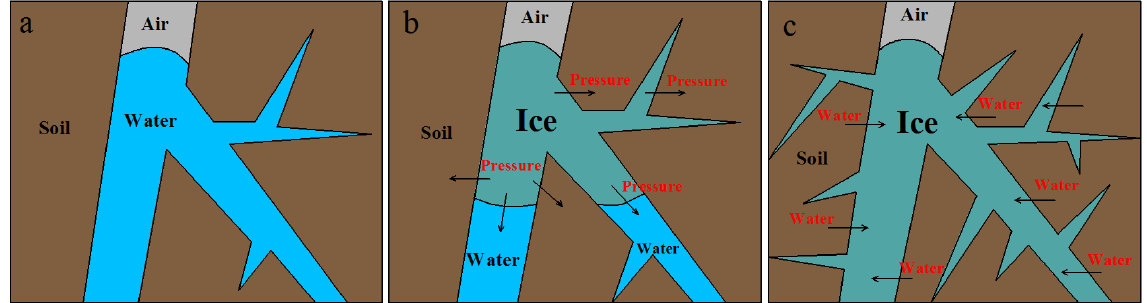
Figure 1. The phase change and migration of soil moisture during freezing process. ( a ) Three-phase distribution of solid, liquid and gas in soil before freeze; ( b ) During the freezing process, the upper layer of soil pore water begins to freeze, producing pressure on the surrounding soil and the lower layer of water; ( c ) After the pore water freezes, ice crystals grow and destroy the soil structure [51].